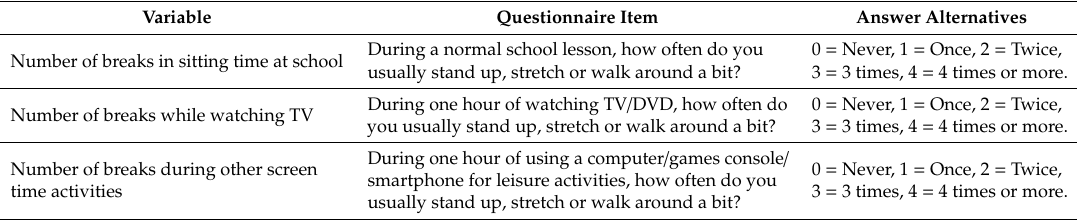
Table 1. Overview of included questionnaire items and their response